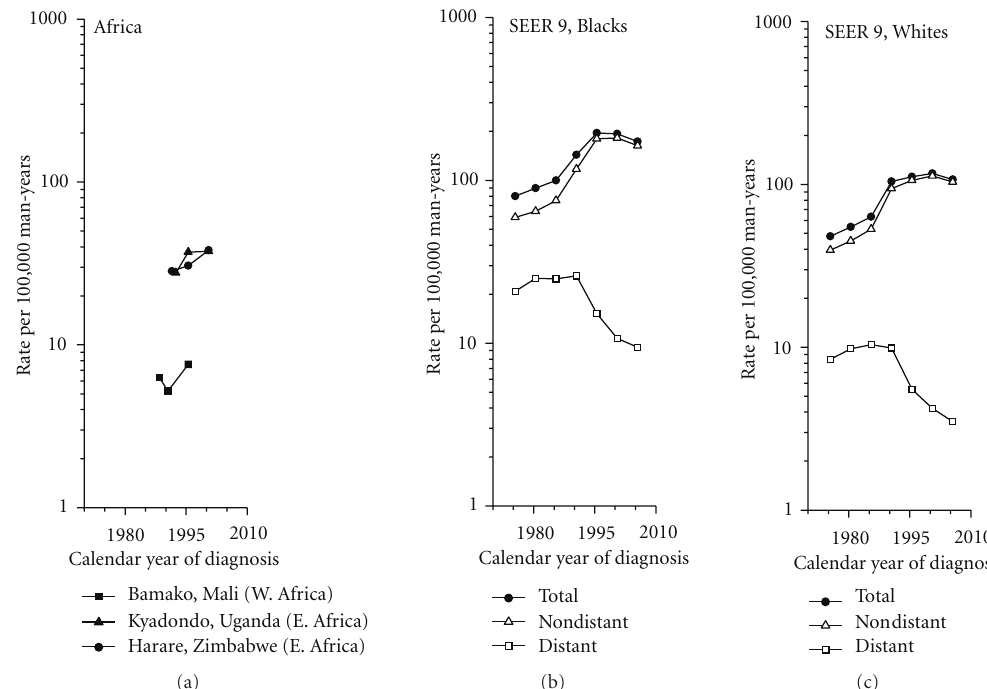
Figure 1: Age-adjusted (Segi’s world standard) prostate cancer incidence in Sub-Saharan Africa and the United States, 1973–2007. (a) Africa: total prostate cancer rates from registries in three African cities; the populations of both Mali and Uganda were > 95% black, and the rates for Zimbabwe were specific for black Africans. US: SEER nine registries combined for blacks (b) and whites (c): total and by SEER historical stage: nondistant and distant. All rates are for 3–5 year time periods (see Table